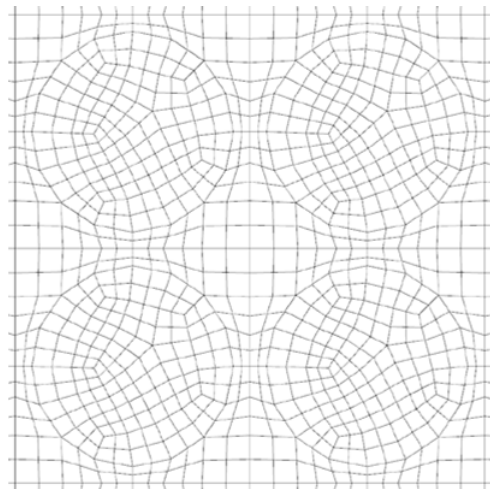
Figure 1. Mesh Composition in Core Area (X-Y, Z=0)